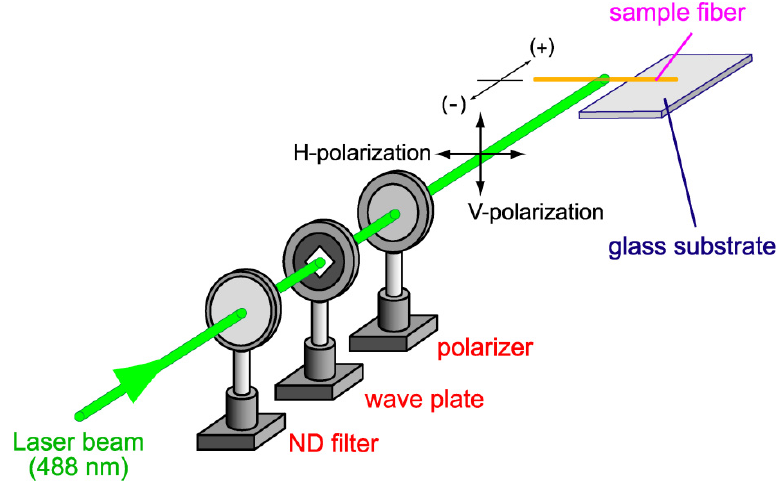
Figure 2. Schematic experimental set-up for photoirradiation of the molecular